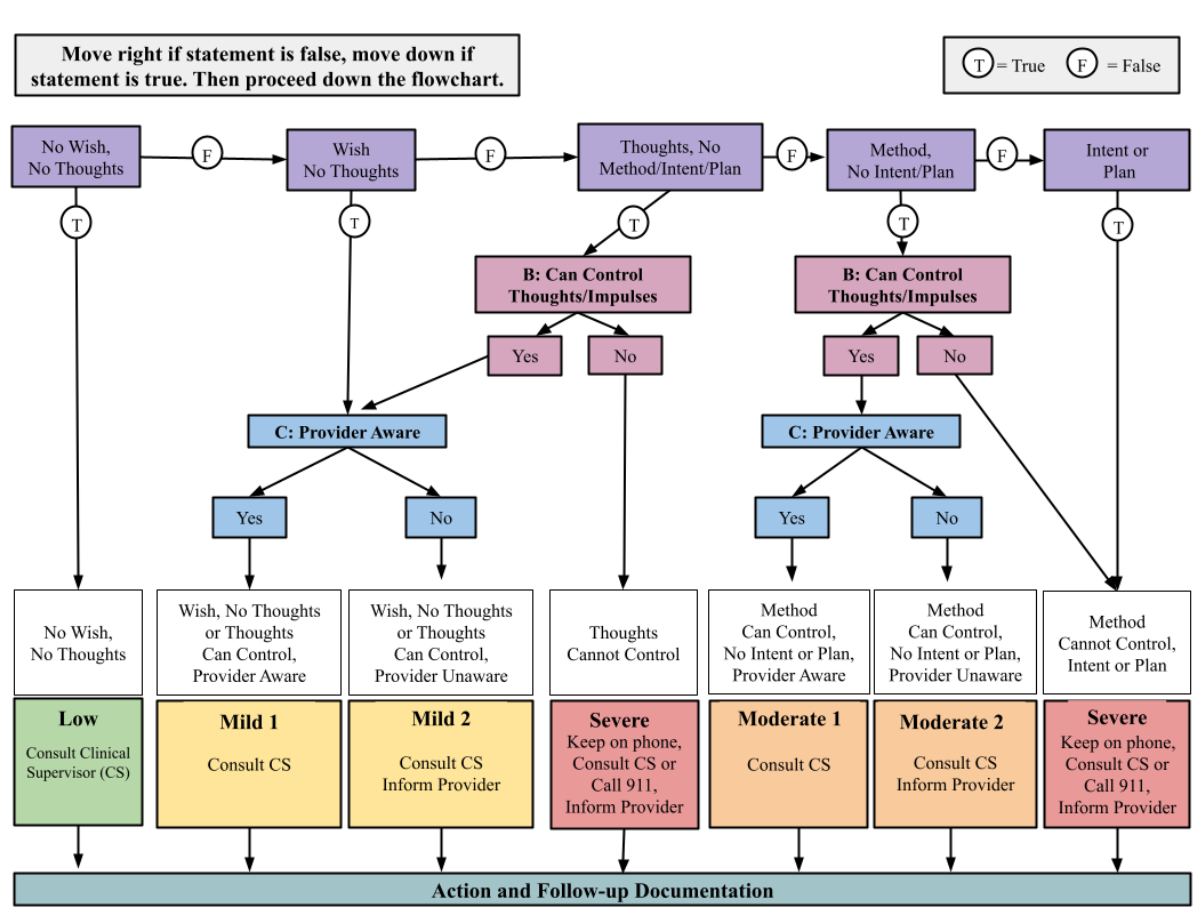
Figure 3. Suicidality assessment protocol flowsheet. CS: clinical